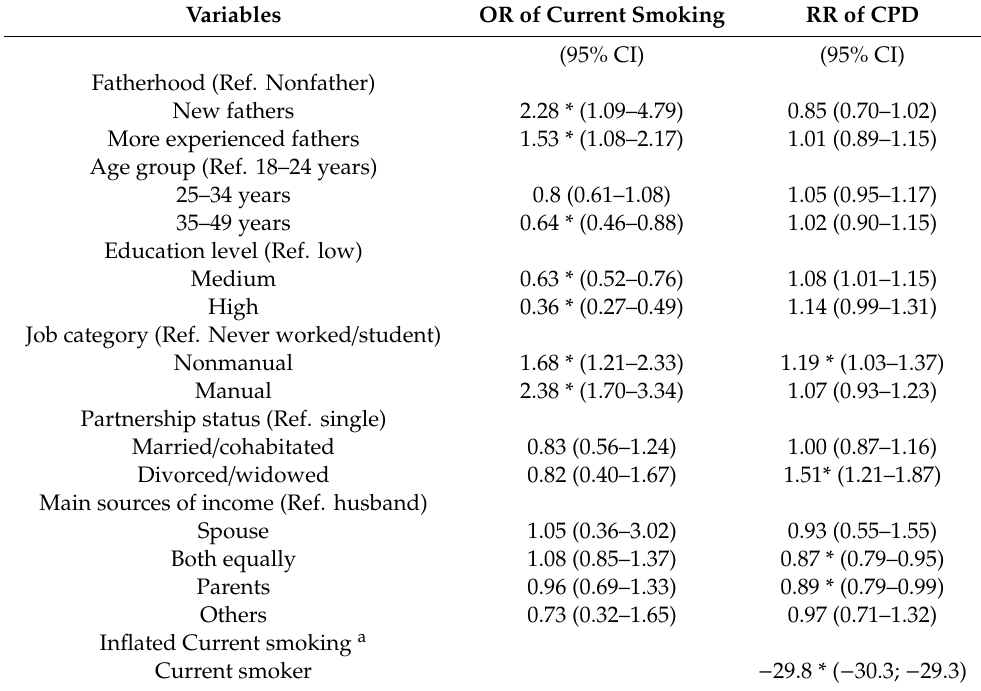
Table 2. Logistic regression of current smoking and zero-inflated negative binomial regression of CPD with independent